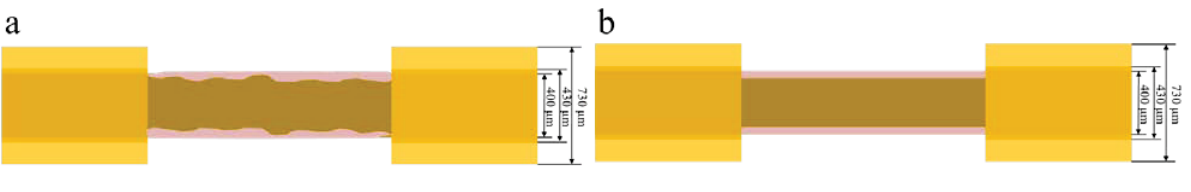
Figure 7. Schematic of an optical fiber: ( a ) wavy pattern; and ( b ) excessive